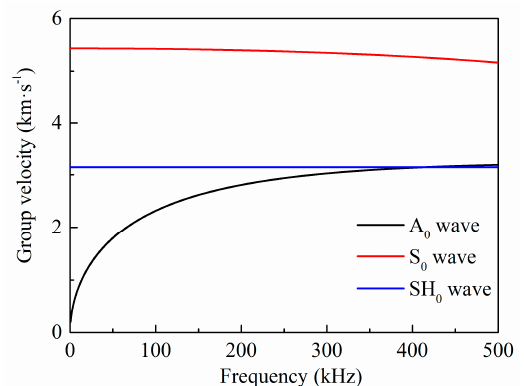
Figure 2. Group velocity verse frequency for SH 0 wave and Lamb waves in a 2 mm-thick aluminum plate.